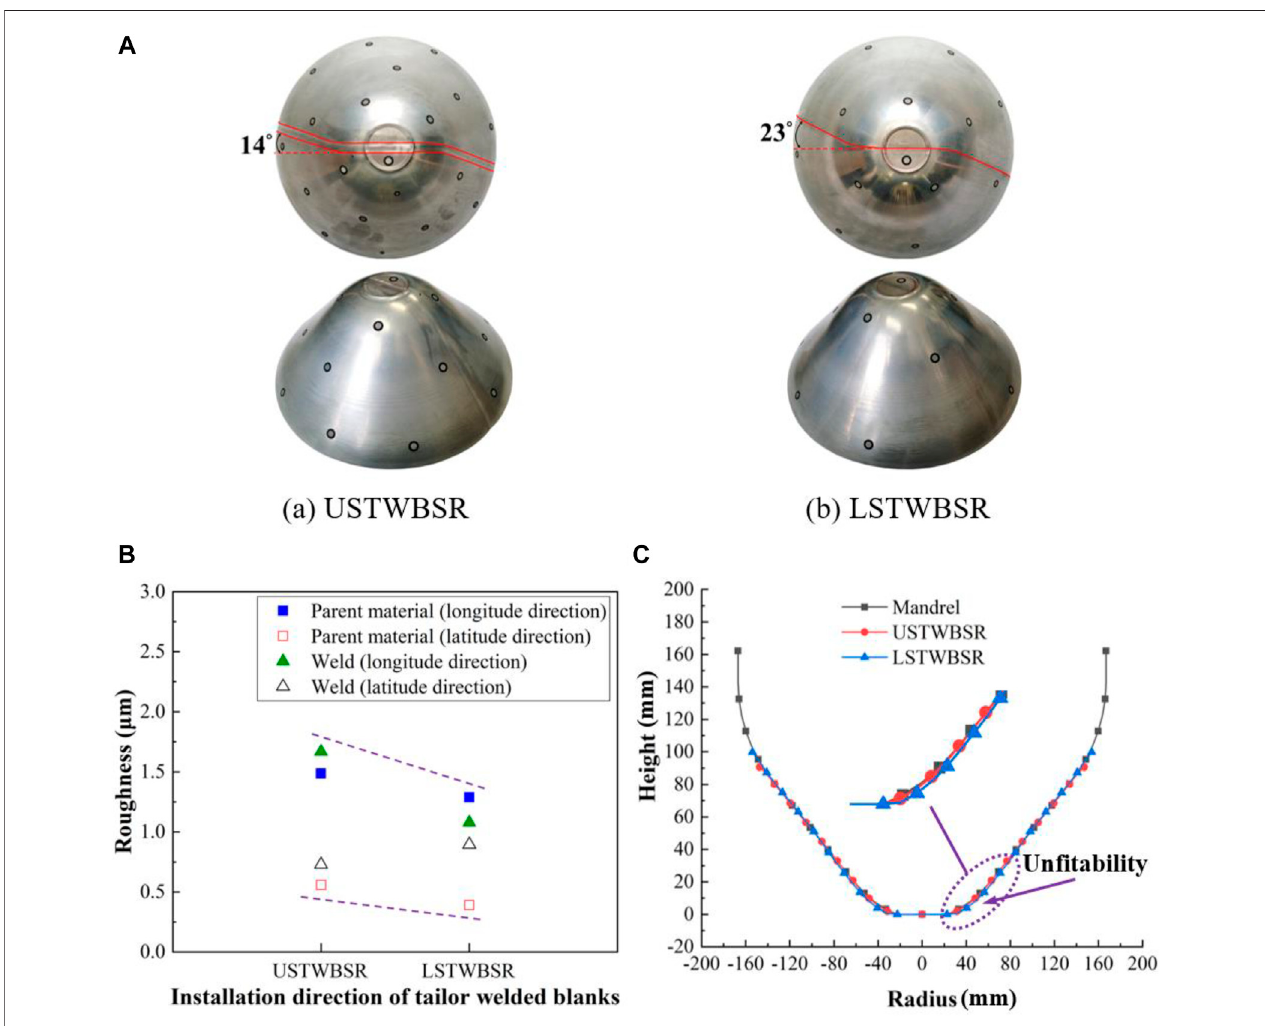
FIGURE10| Experimentalresults: (A) topandobliqueviewsofspunpartsundertheinstallationmethodoftailorweldedblanksof(a)USTWBSRand(b)LSTWBSR; (B) surface roughnesses of spun parts and (C) forming pro fi le of spun parts.